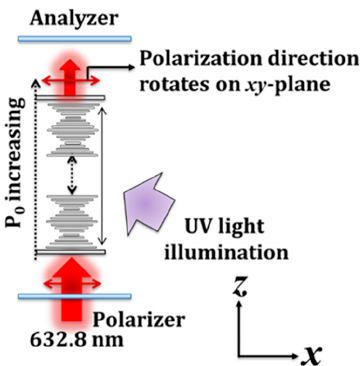
Figure 3. Experimental setup to investigate the rotation angle of the linear polarization of a He–Ne laser during UV illumination. The orientation of linear-polarization of the transmitted beam can be rotated in the x – y